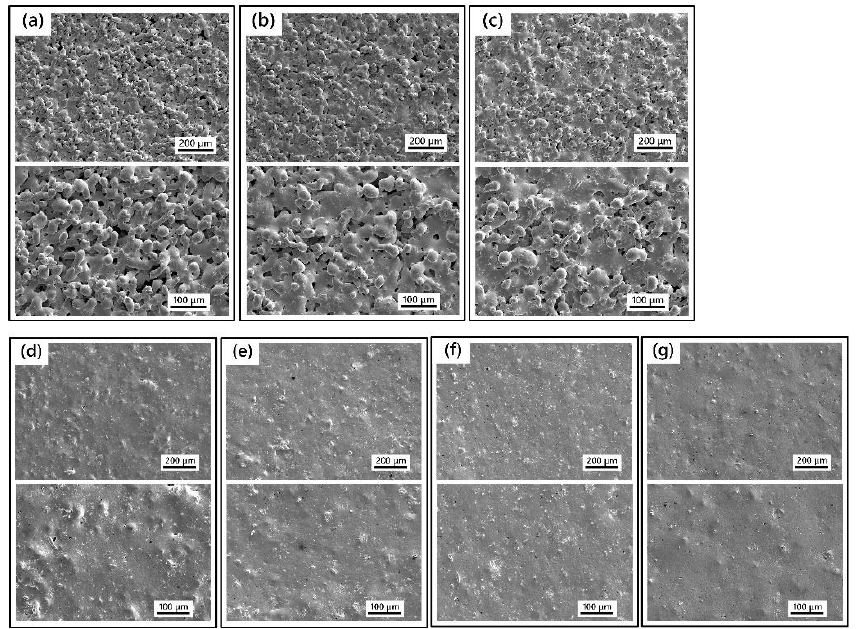
Figure 4. SEM images of melting effect of tin powder with different laser energy densities. The energy densities from ( a – g ) are 1.19, 1.24, 1.25, 1.30, 1.32, 1.35, and 1.37 J/cm 2 .